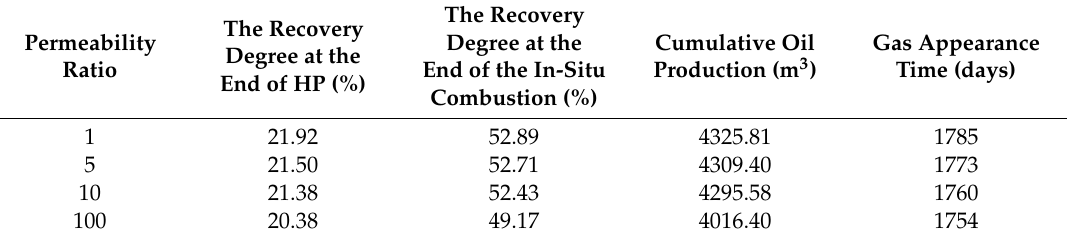
Table 15. Dynamic production indicators under different permeability ratio.